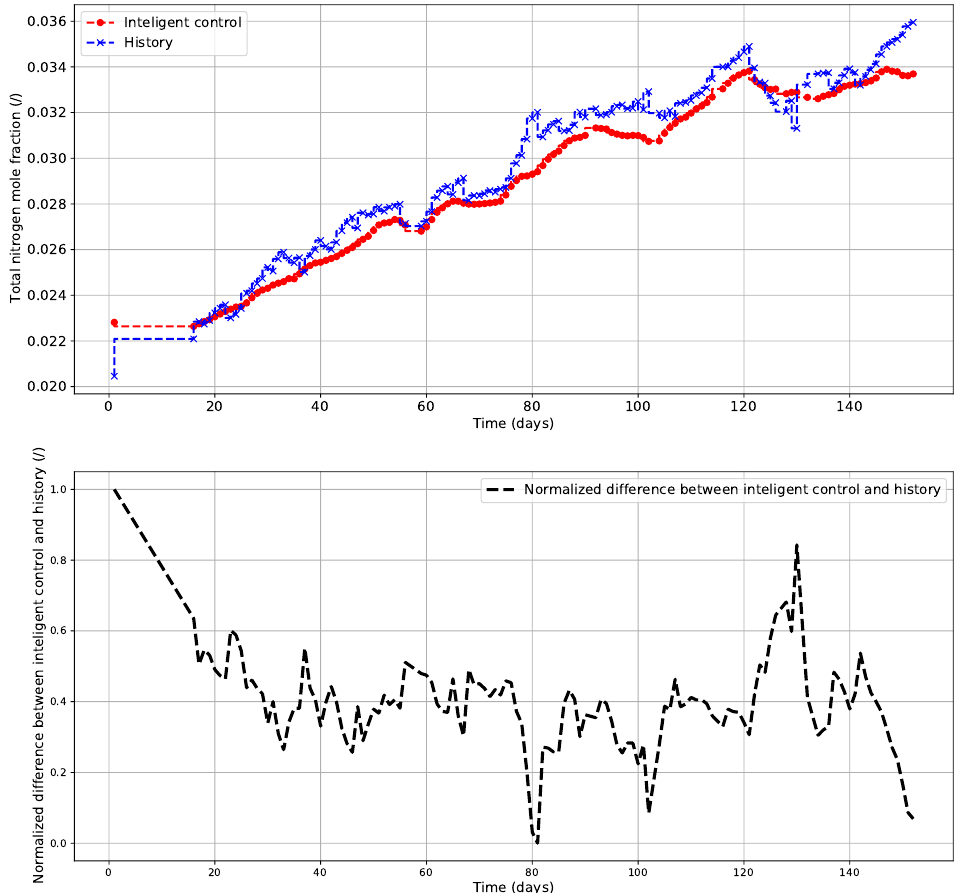
Figure 6. Influence of the developed control on the total nitrogen content in the gas withdrawn from the analyzed